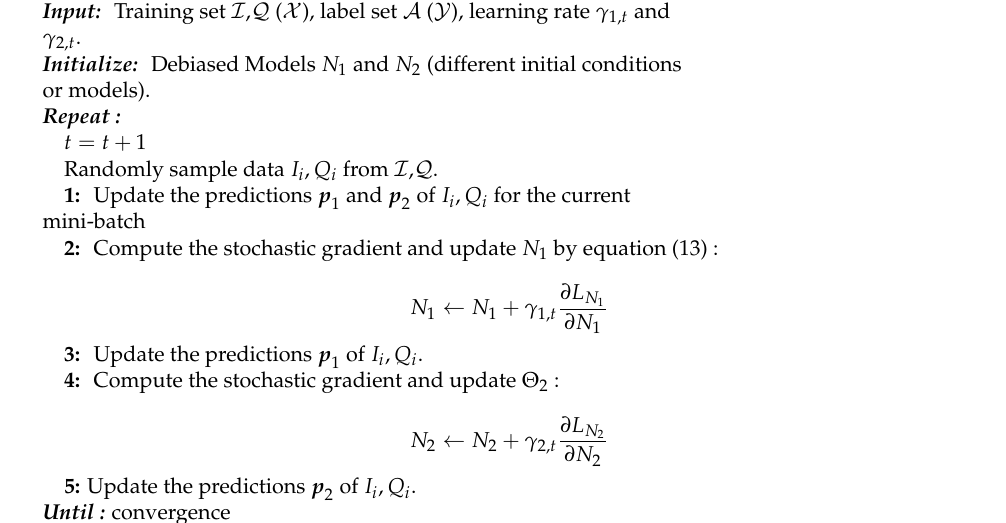
Algorithm 1: Language Bias-Driven